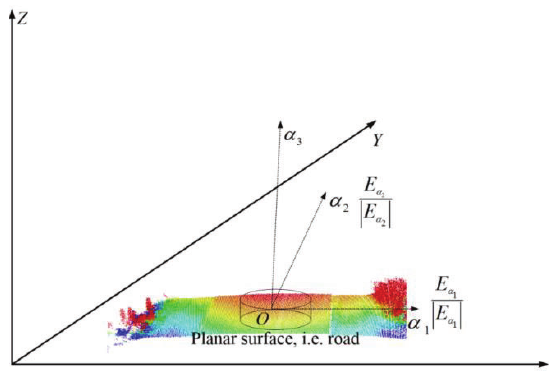
Figure 2. Point cloud spread and shapes of road surface and other dominant objects present in the MLS data.